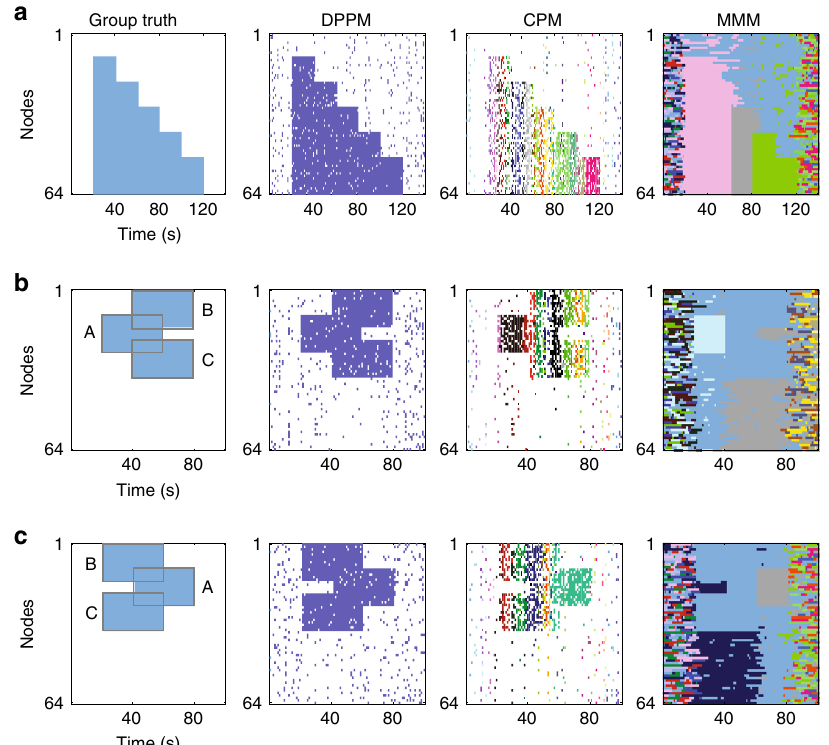
Fig. 3 In three additional examples of dynamic community evolution, DPPM outperforms two existing methods. Community detection for each method in the case of a community contraction, b community splitting, and c community merging. From left to right in each sub fi gure: true community evolution, DPPM with parameters m = 4 and k = 2, CPM with parameter m = 4, and MMM with parameters γ = 0.1, ω = 0.1; see Fig. 4 and Supplementary Figs. 3 – 6 for results with different parameter choices. Color indicates community membership. In all cases, the largest community detected by DPPM is most consistent with the true community population means [ − 0.59, − 0.04]; and p = 0.0016, t-statistic = −